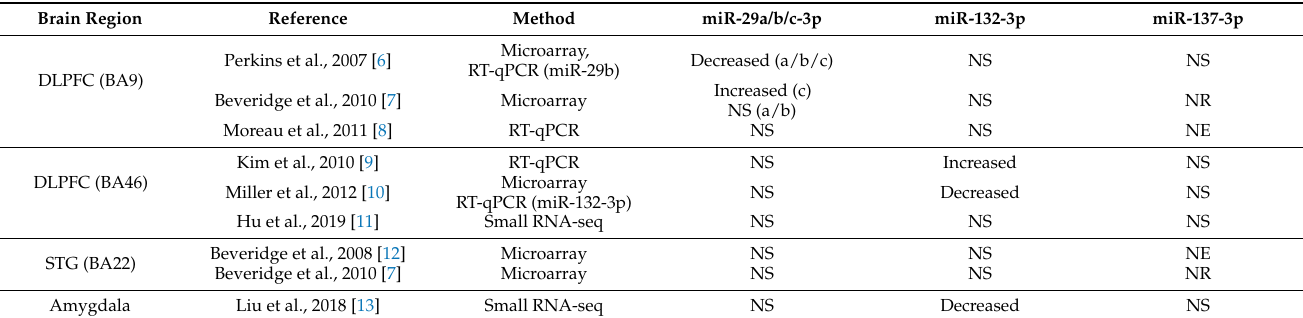
Table 5. MiRNA levels in postmortem brains from patients with SCZ.